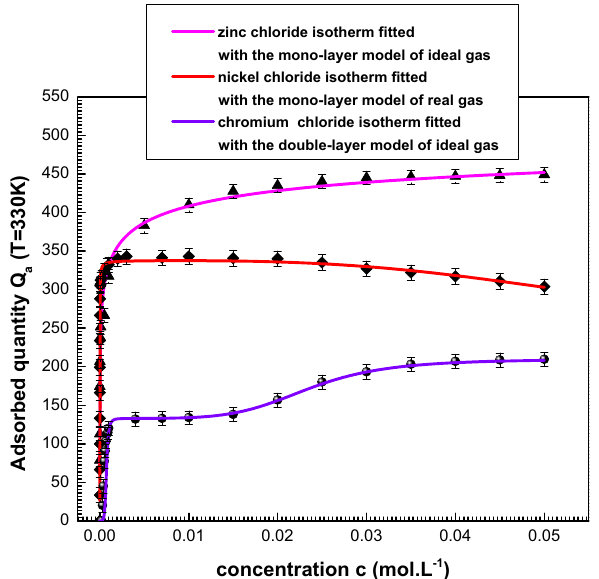
Figure 3. Experimental adsorption isotherms simulated with the adequate statistical physics model at 300 K.